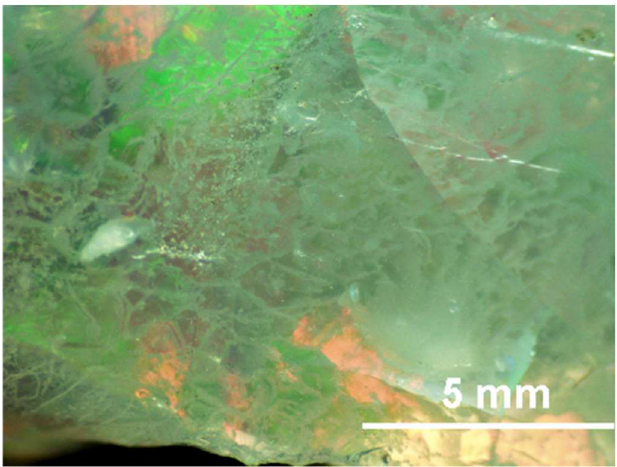
Figure 5. The digit pattern in Opal-09 is undeveloped and has a dendritic matrix.